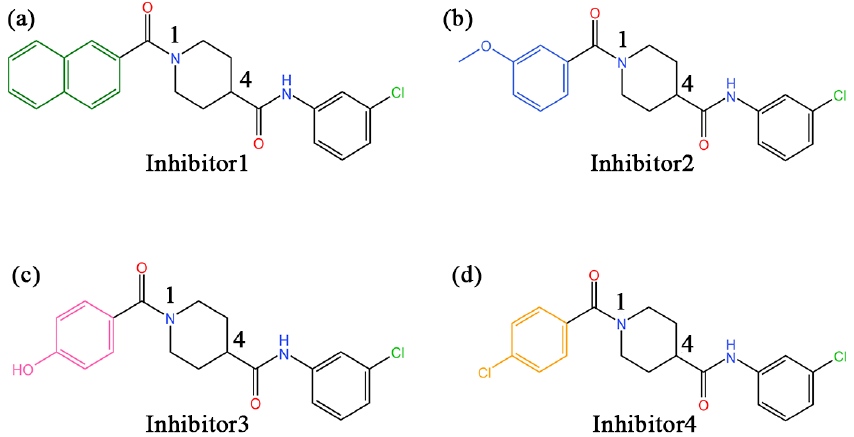
Figure 2. ( a – d ) The 2D structures of inhibitors 1–4 and the groups in each inhibitor, from left to right, are referred to as the head aromatic ring, the head carbonyl group, the piperidine parent nucleus, the tail amide bond, and the tail benzene ring, respectively, in this paper.